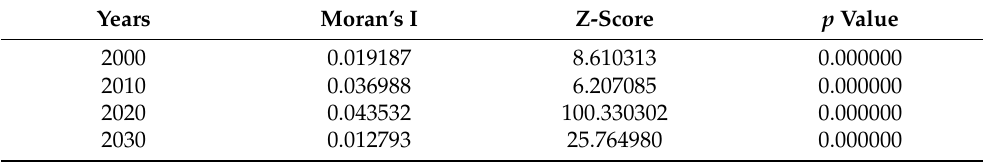
Table 3. Spatial autocorrelation Moran’s I report of PWD distribution in each year.